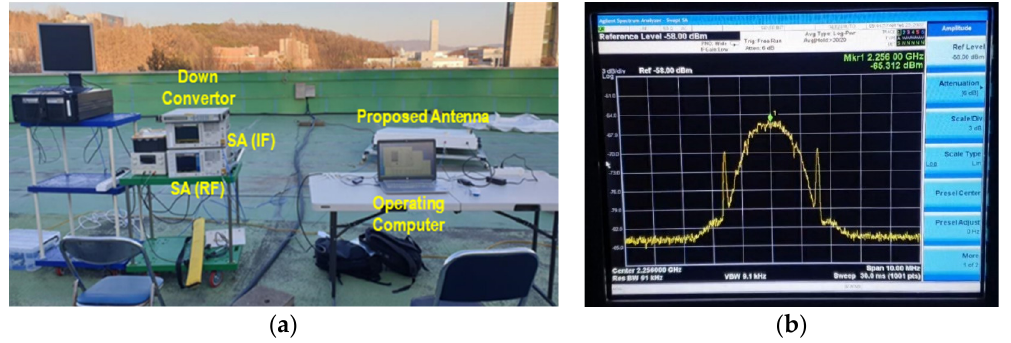
Figure 17. ( a ) Field test environment of the implemented phased-array antenna and ( b ) spectrum analyzer results of the implemented phased-array antenna from KOMPSAT-5.